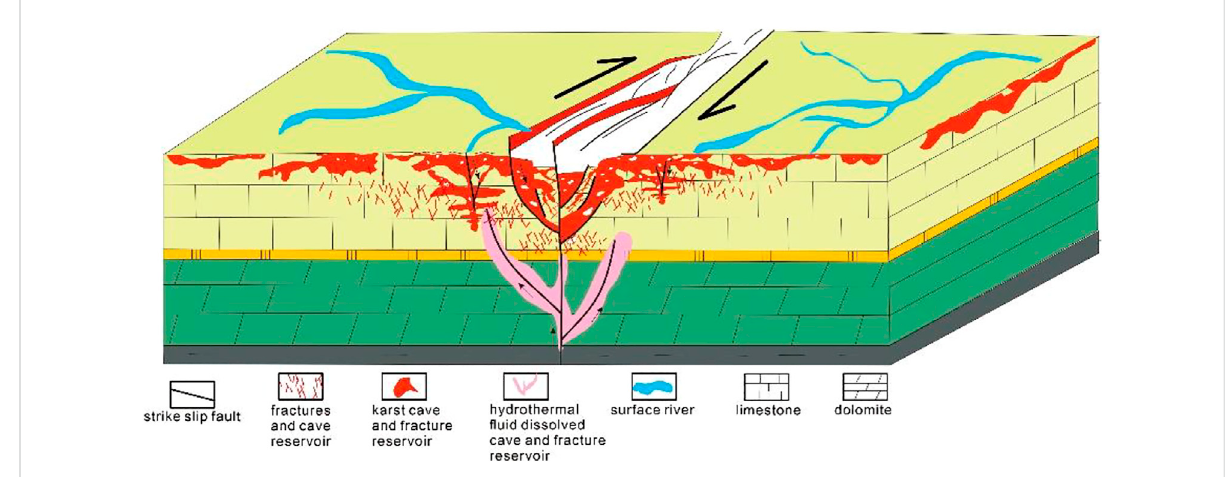
FIGURE 4 Reservoir model of different types controlled by strike-slip faults in the Tarim